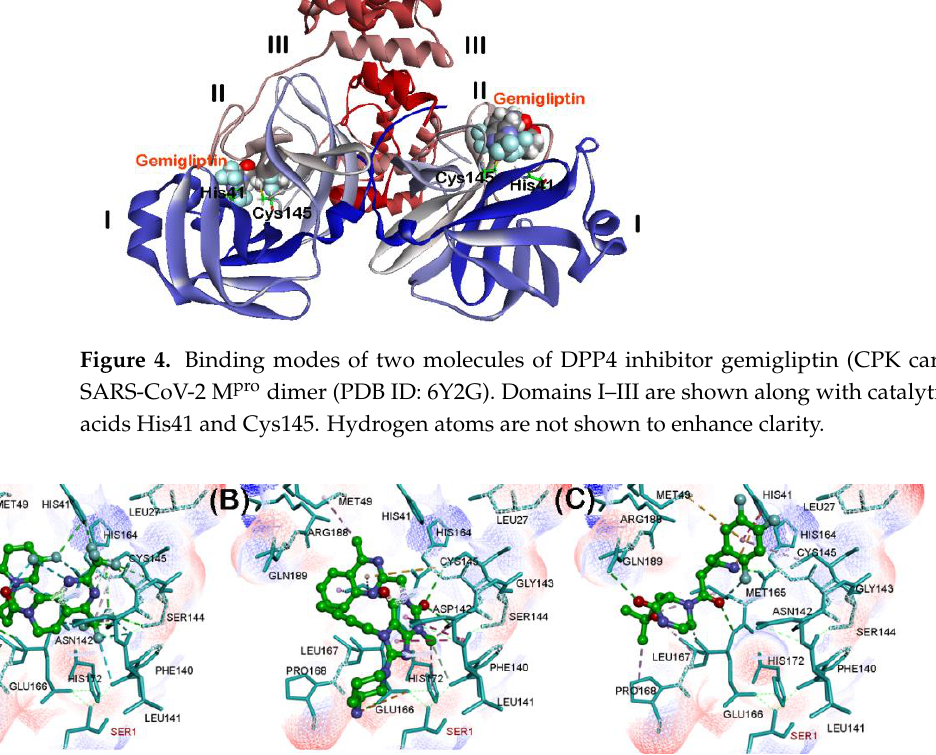
Figure 5. Binding modes of DPP4 inhibitors gemigliptin ( A ), linagliptin ( B ) and evogliptin ( C ) in the SARS-CoV-2 M pro dimer (PDB ID: 6Y2G). The amino acid Ser1 from chain B is colored in red. Hydrogen atoms are not shown to enhance clarity.